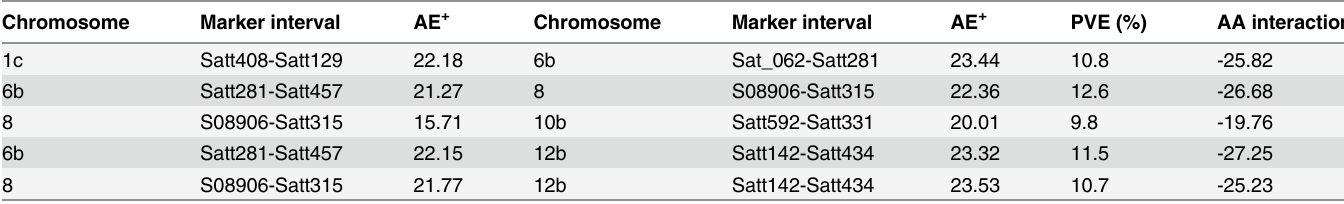
Table 4. Epistatic QTLs identi fi ed for root dry weight with LOD value < 5.0 in Dunbar/PI 326582A population. Chromosome Marker